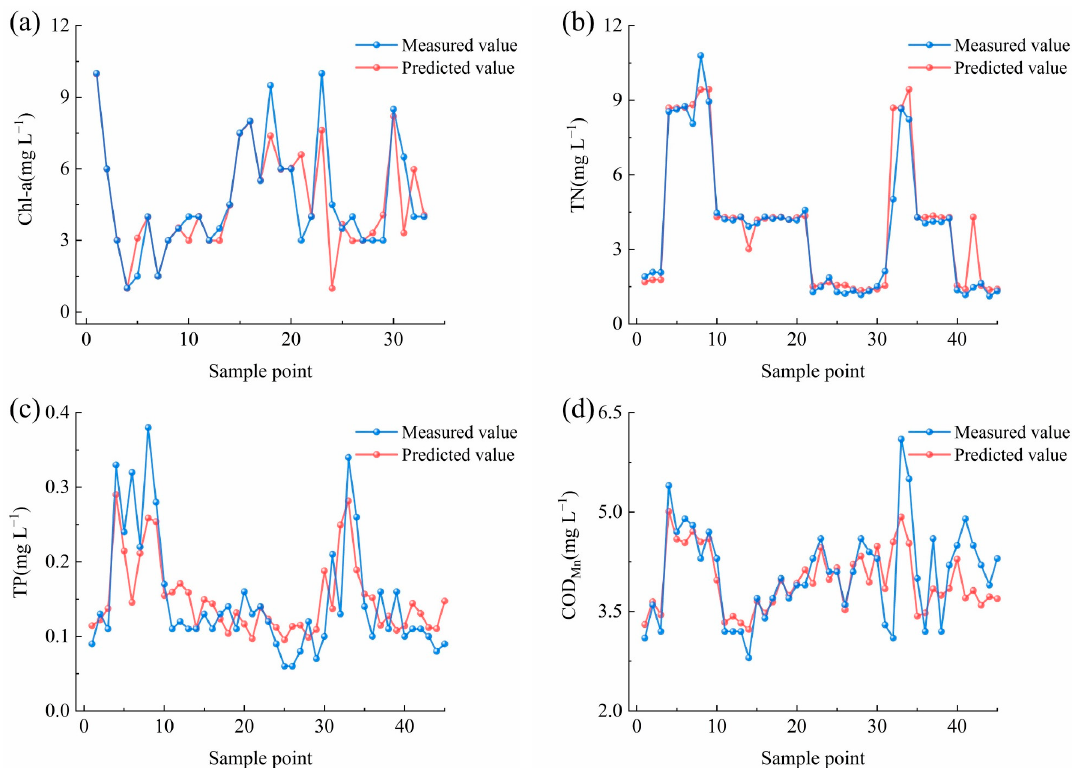
Figure 8. Comparison of measured and predicted values: ( a ) Chl-a, ( b ) TN, ( c ) TP, and ( d ) COD Mn .